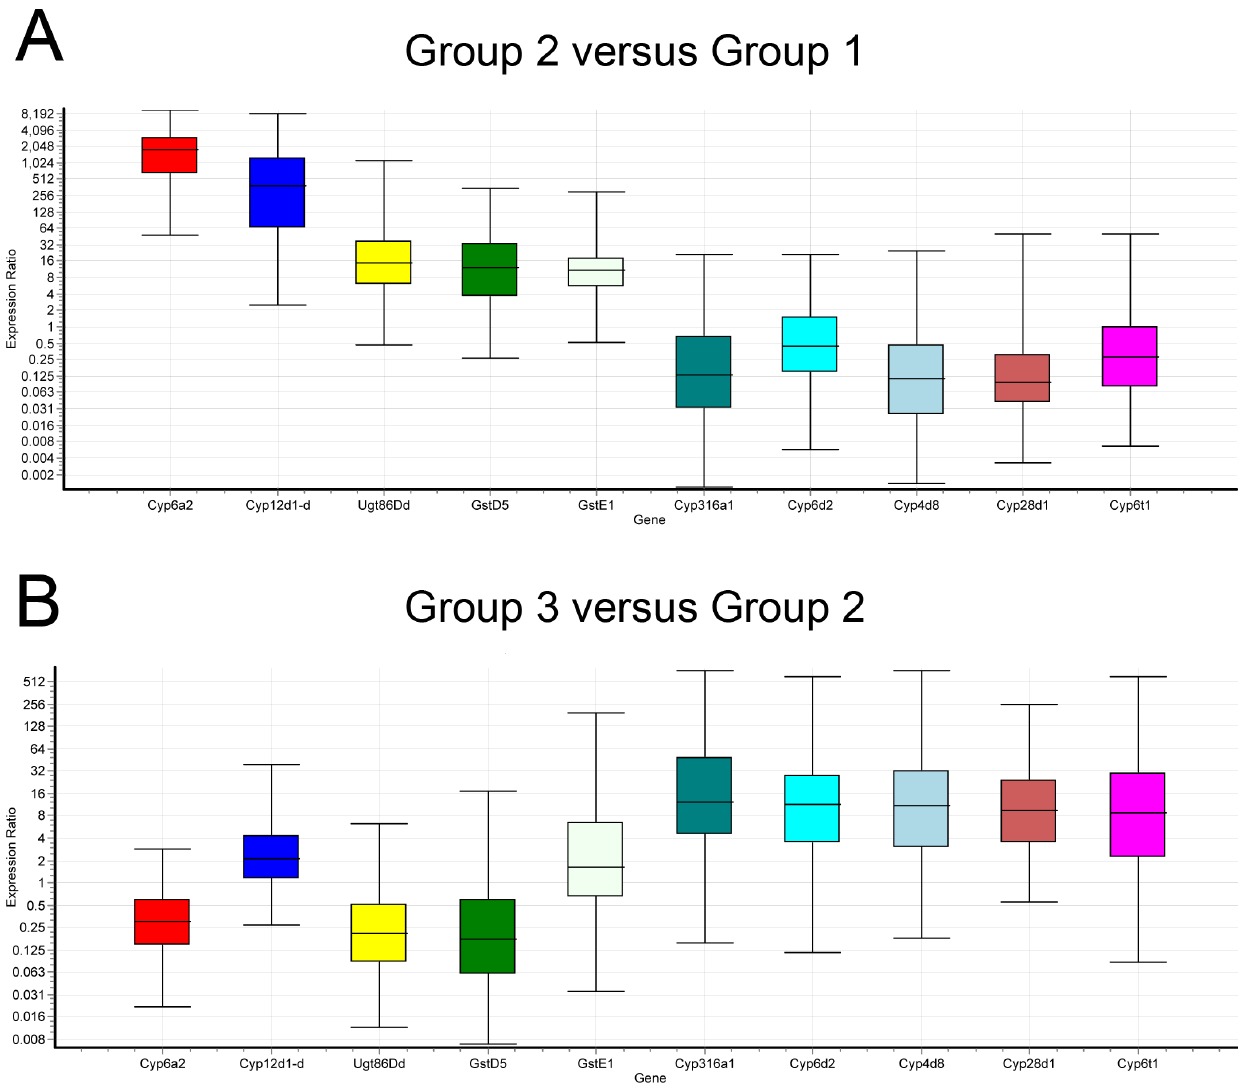
Figure 6. The qPCR results confirm the microarray data. A) Relative expression distribution (Y-axis) of ten selected genes is shown as a ratio comparing Ama-KTT/M/2 and Canton-S (group 2 versus group 1). Each measurement contains 15 replicates (3 replicates for each of the five biological controls of groups 1 and 2). B) Gene expression differences between Ama-KTT/M/2 treated with a -amanitin and Ama-KTT/M/2 (group 3 versus group 2) are compared. Group 3 contributes to 18 data points (three replicates for each of the six biological controls), while group 2 contributes to 15 data points, as previously mentioned. All comparisons were normalized with two reference genes, Sucb and alpha-Tub84B . Ratios above one indicate that a gene is up-regulated in the